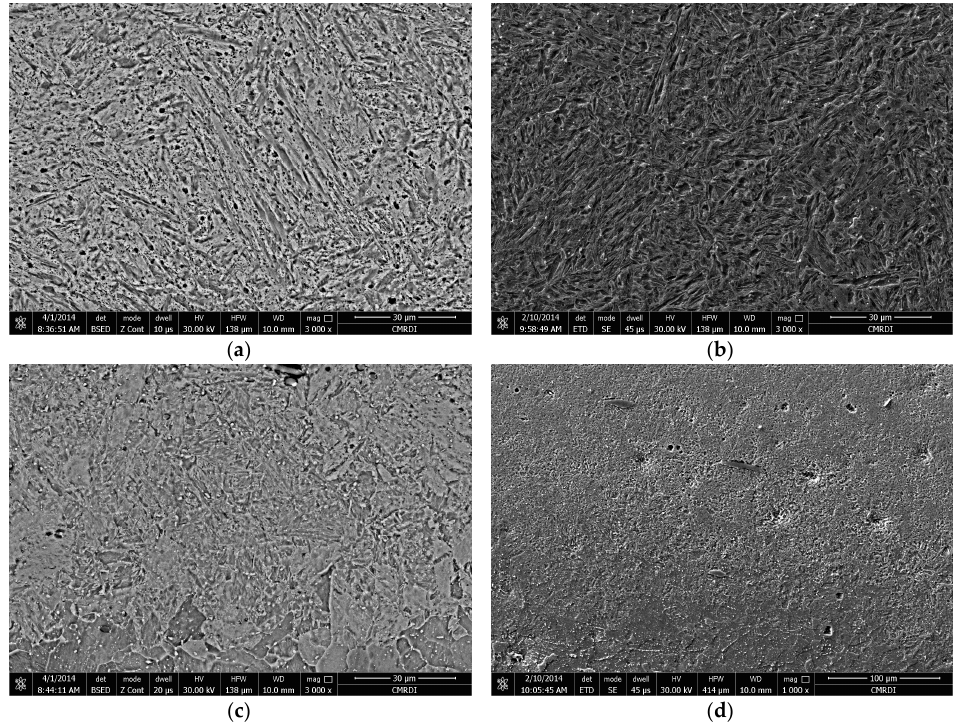
Figure 7. XRD spectra for various LHT AISI 416 specimens processed at laser power 1000 W and scanning speeds of ( a ) 0.5 and ( b ) 3 m ∙ min − 1 .